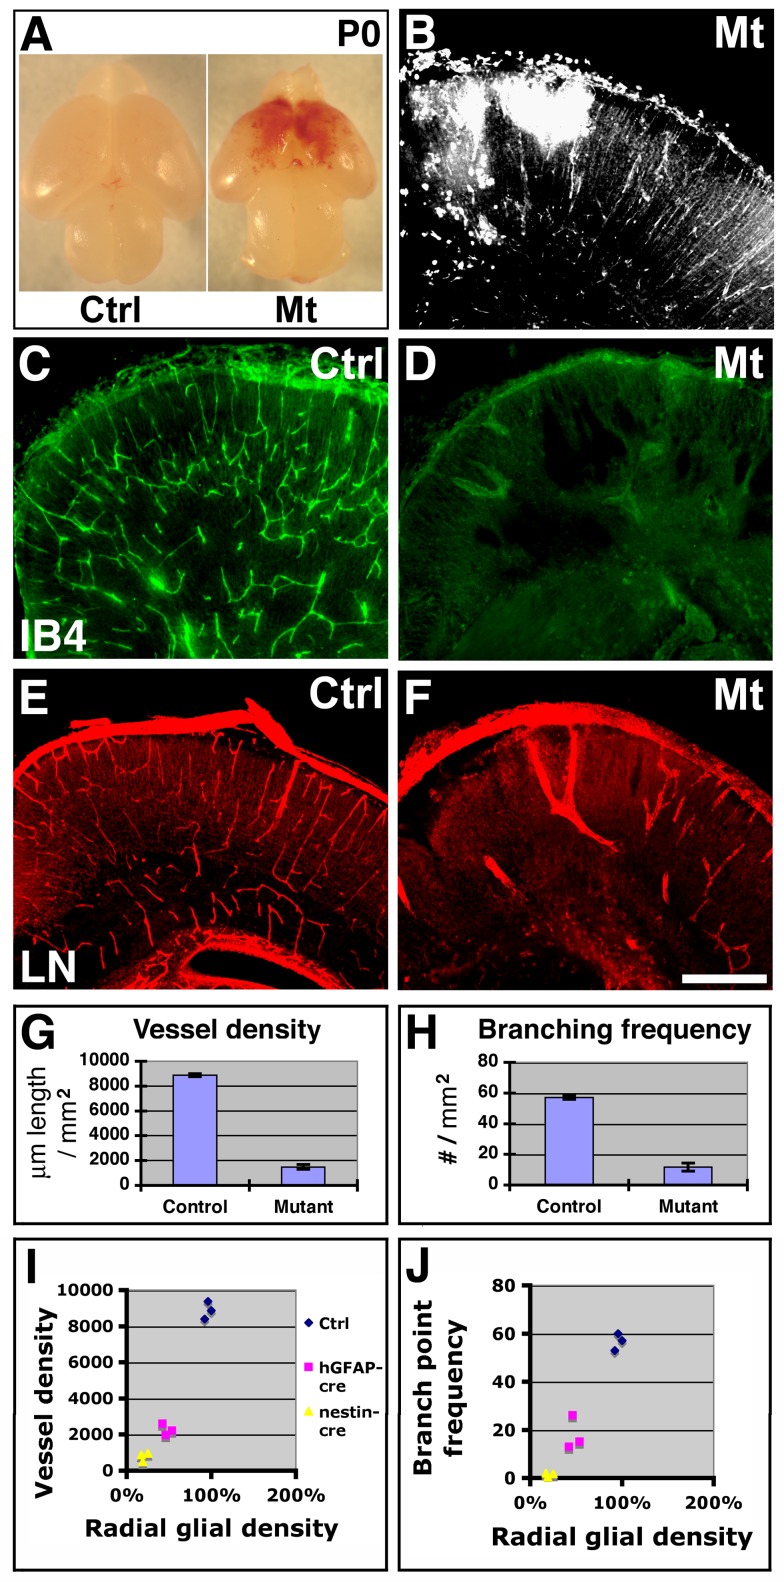
Ablation of neural progenitors results in defective cortical angiogenesis.(A–B) Neonatal brain hemorrhage in orc3 mutants. Immunoglobulin reactivity further confirmed patterns of hemorrhage (B). (C–F) Vessel morphology at P0 along the anterior-posterior axis. IB4 (in green) and laminin (LN, in red) staining revealed severe loss of vessels in mutants in both the anterior (C and D) and posterior (E and F) cortex. (G–H) Quantitative analysis of cortical plate vessel density and branching frequency. Dramatic reductions in both vessel density (G) and branch point frequency (H) were observed (p = 1.76×10−14 and p = 1.01×10−8, respectively; n = 9). (I–J) Correlation between radial glial density and vessel density (I) as well as between radial glial density and vessel branching frequency (J) in the medial cortex of control, orc3/nestin-cre, and orc3/hGFAP-cre mutant neonates. The correlation coefficient was 0.97 for the former (I) and 0.98 for the latter (J). Scale bar (in F): 500 µm for (B–F).